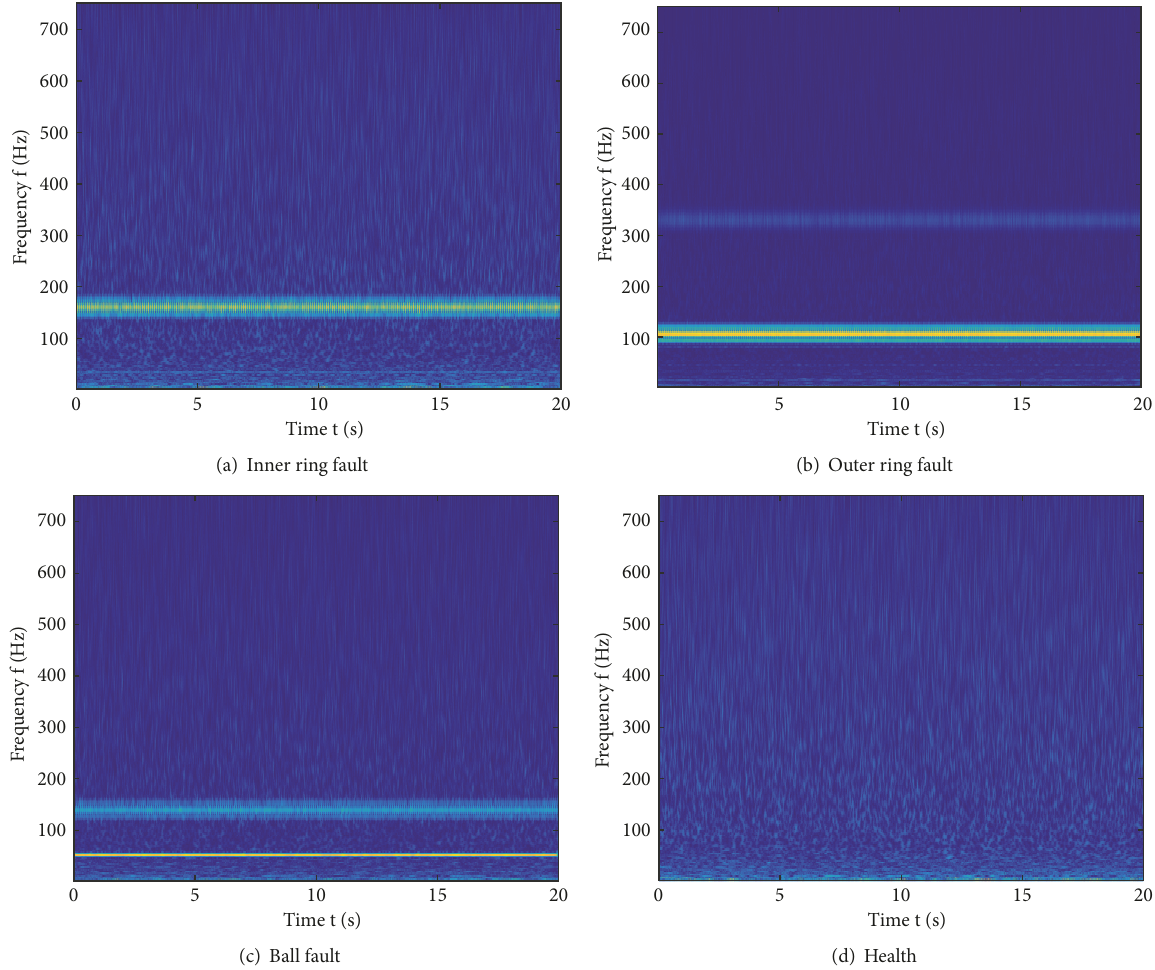
Figure 10: Signal time-frequency graphs of the experimental station of Case Western Reserve University.